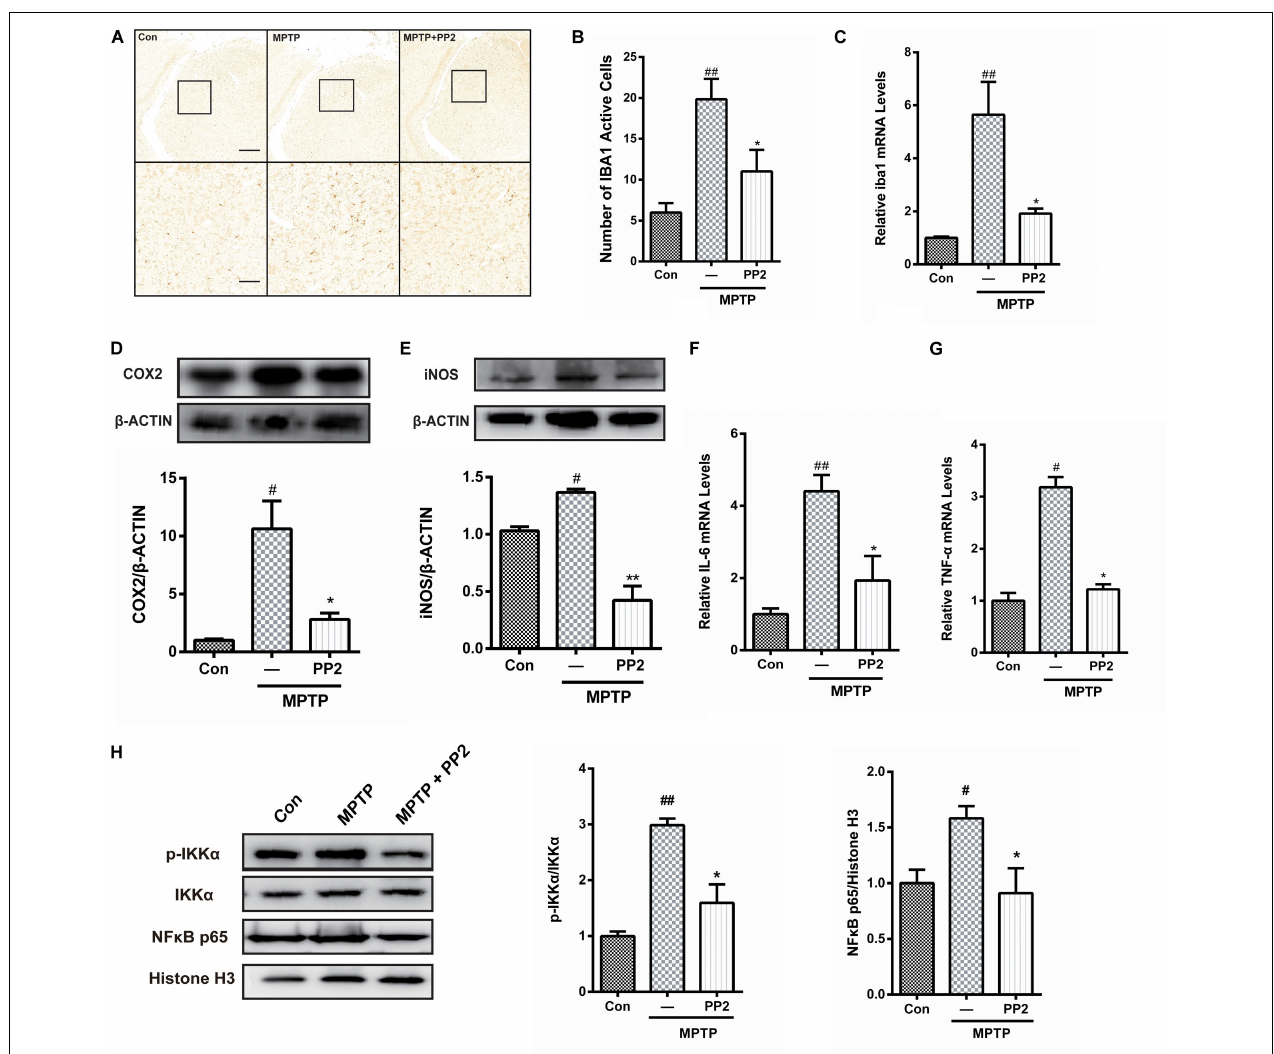
FIGURE 5 | Src inhibition reduced activation of microglial cells and neuroinflammation in 1-methyl-4-phenyl-1,2,3,6-tetrahydropyridine (MPTP)-treated mice. (A) The activation of microglia in SNpc showed by IBA1 immunostaining (scale bar: top, 200 µ m; bottom, 50 µ m). (B) The number of IBA1-positive cells per 100 cells was counted and provided in a histogram. Data are expressed as means ± SEM. n = 4. ## P < 0.01 vs. control group,* P < 0.05 vs. lipopolysaccharide (LPS) group. (C) The mRNA expression level of IBA1 in SNpc was determined by quantitative reverse transcription (qRT)-PCR. Data are expressed as means ± SEM. n = 4. ## P < 0.01 vs. control group,* P < 0.05 vs. LPS group. (D,E) The protein expression level of cyclooxygenase-2 (COX2) and iNOS were determined by western blot with anti-COX2 and anti-iNOS antibodies. Data are expressed as means ± SEM. n = 4. # P < 0.05 vs. control group,* P < 0.05 and ** P < 0.01 vs. LPS group. (F,G) The mRNA expression level of IL-6 and TNF- α was determined by qRT-PCR. Each bar represents the mean ± SEM. n = 4. # P < 0.05 and ## P < 0.01 vs. control group, * P < 0.05 vs. MPTP group. (H) The protein expression level of p-IKK α , IKK α , NF- κ B p65, and histone H3 were measured by western blot. Each bar represents the mean ± SEM. n = 4. # P < 0.05 and ## P < 0.01 vs. control group, * P < 0.05 vs. MPTP group.